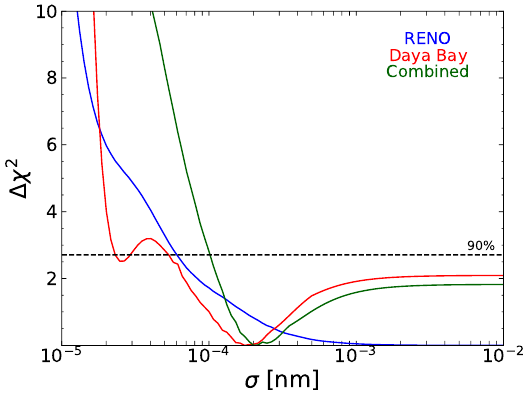
Figure 4 . The reduced (cid:31) 2 as a function of (cid:27) relative to its minimum value, obtained from the anal- ysis of RENO (blue), Daya Bay (red) and from the combined analysis of both experiments